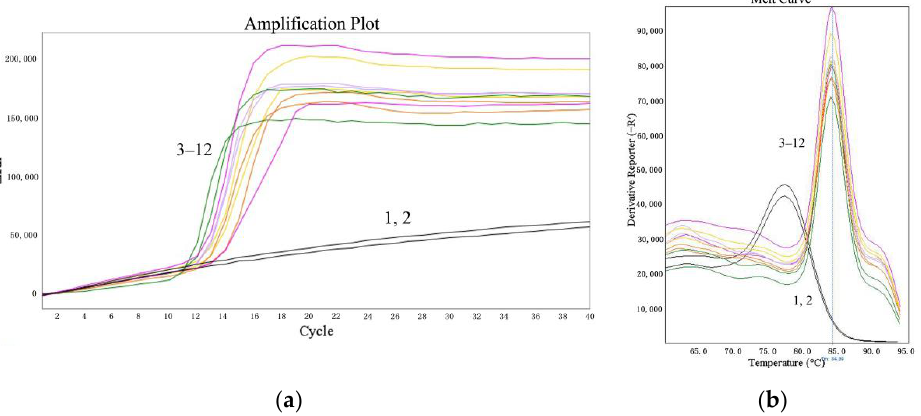
Figure 4. Suitability of the LMTIA assay for distinguishing the DNA extracted from sweet potato starch mixed with cassava starch. ( a ): the amplification plot of the LMTIA assay; ( b ): the melt curve of the LMTIA assay. 1, 2: ddH 2 O; 3, 4: 1 ng cassava DNA; 5 – 12: the DNA extracted from sweet potato starch adulterated with cassava starch at 5%, 1%, 0.1%, and 0.01% ( w / w ). of the LMTIA assay. 1, 2: ddH 2 O; 3, 4: 1 ng cassava DNA; 5–12: the DNA extracted from sweet